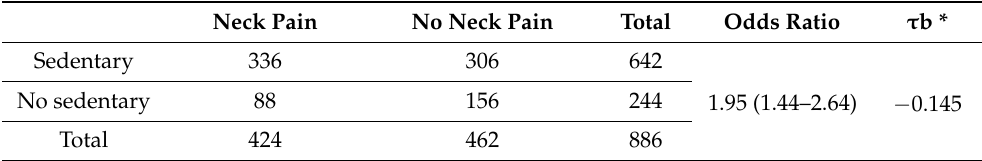
Table A3. Odds ratio between sedentary behavior and neck